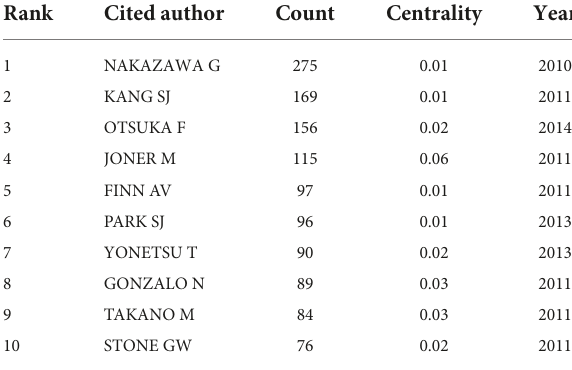
TABLE 6 The top 10 co-cited author sorted by the number of